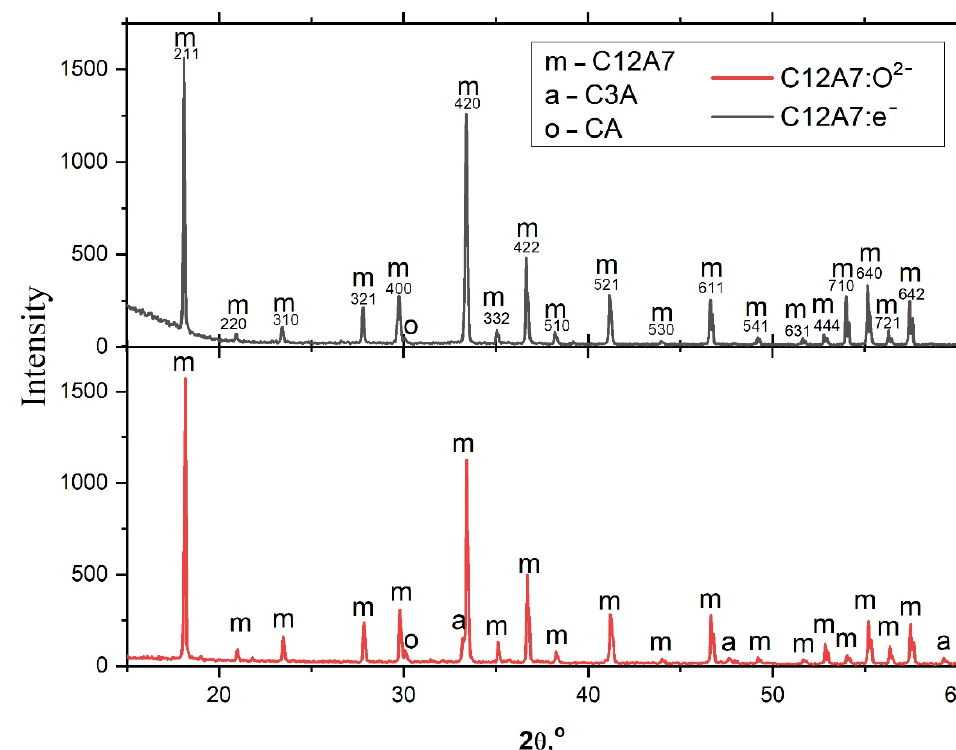
Figure 2. XRD patterns of initial samples C12A7:e − ( upper ) and C12A7:O 2− ( lower ).